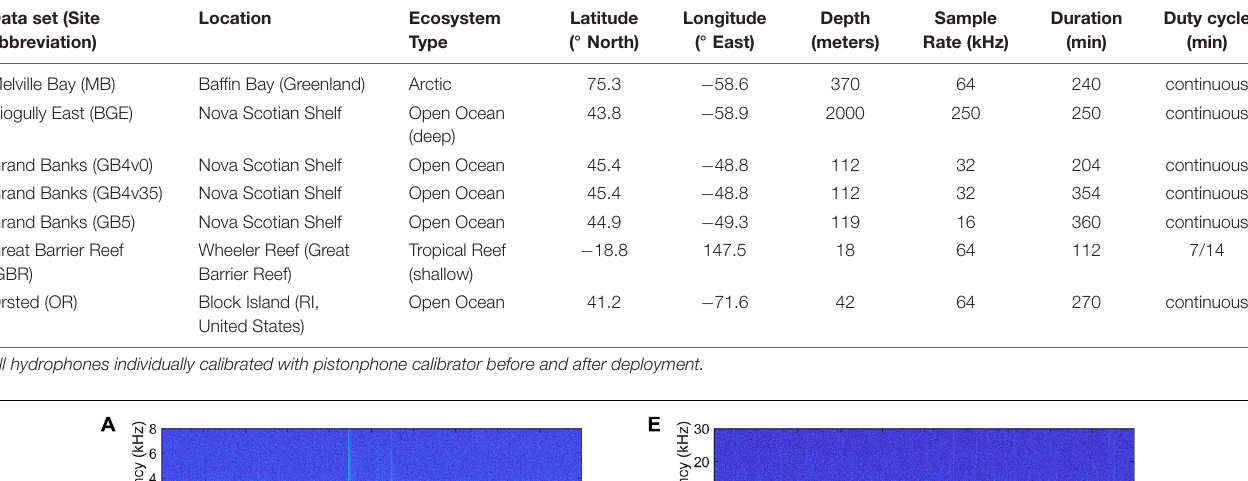
TABLE 3 | Soundscape code dataset descriptions and data collection